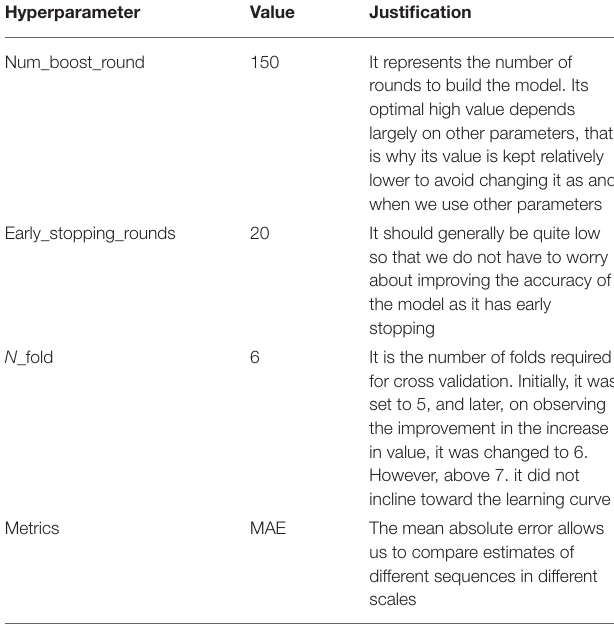
TABLE 12 | Hyperparameter selection for